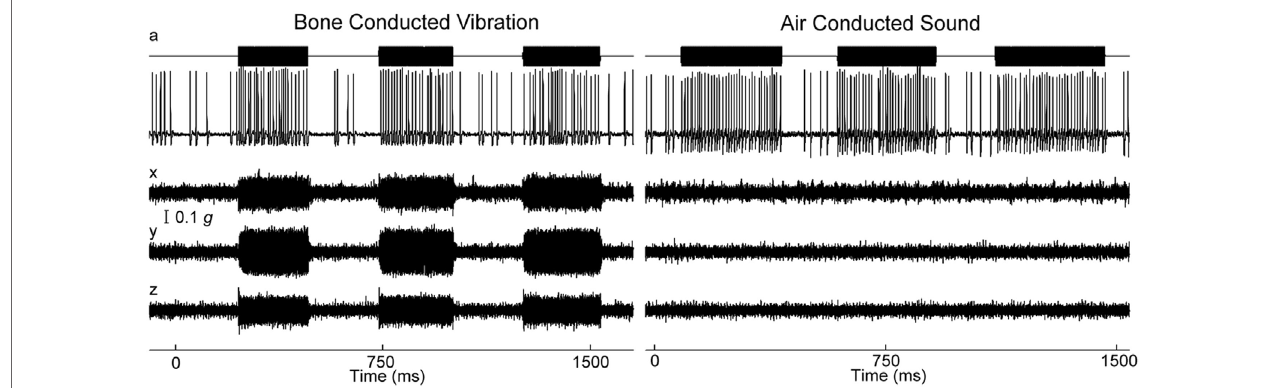
FigURe 3 | Time series of firing of an irregular otolith neuron during stimulation by bone-conducted vibration (BCV) and air-conducted sound (ACS) at 500 Hz— both stimuli cause stimulus-locked activation. The top trace (a) shows the command voltage indicating when the stimulus is on. The second trace shows the extracellular recording. The three bottom traces ( x, y, z ) show the triaxial accelerometer recording of the stimulus. The left panel is an example of BCV stimulation and the right of ACS stimulation of the same neuron. Note the scale of stimulus intensity in g at the left margin between traces x and y . Reprinted by permission from Springer Nature, Curthoys and Vulovic (29), ©